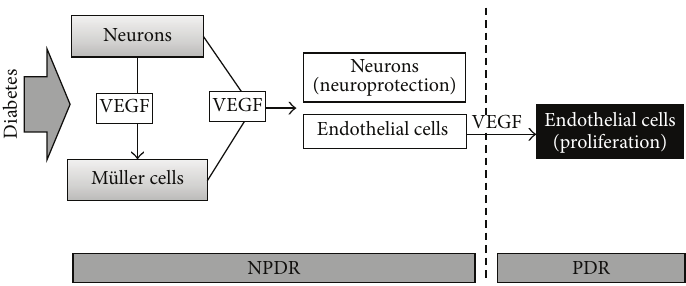
Figure 1: Possible role of VEGF in early DR. Under diabetic stress, VEGF would be immediately released by neurons and by M¨uller cells, which perhaps receive stimulation by the VEGF of neuronal origin. In the nonproliferative phase of DR (NPDR), released VEGF would act on retinal neurons as a neuroprotectant, while it would also bind to its receptors on endothelial cells. A prolonged interaction of VEGF with endothelial cells would lead to the proliferative phase of DR